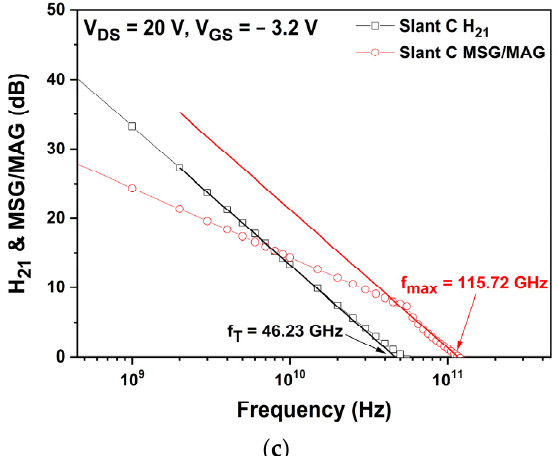
Figure 10. Cut-off frequency (f T ) and maximum frequency (f max ) of the slant-gate structures at V DS = 20 V, V GS = − 3.2 V: ( a ) H 21 and MSG/MAG versus frequency for the slant A structure; ( b ) H 21 and MSG/MAG versus frequency for the slant B structure; and ( c ) H 21 and MSG/MAG versus frequency for the slant C structure.